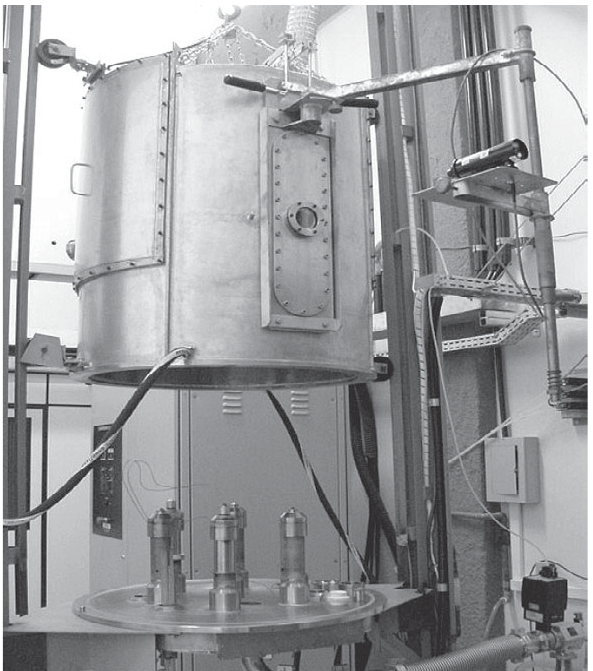
Figure 1. Plasma